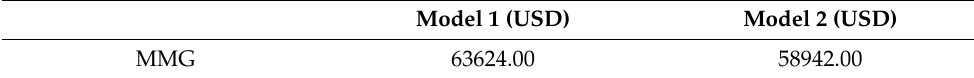
Table 4. Operating cost of MMG under different